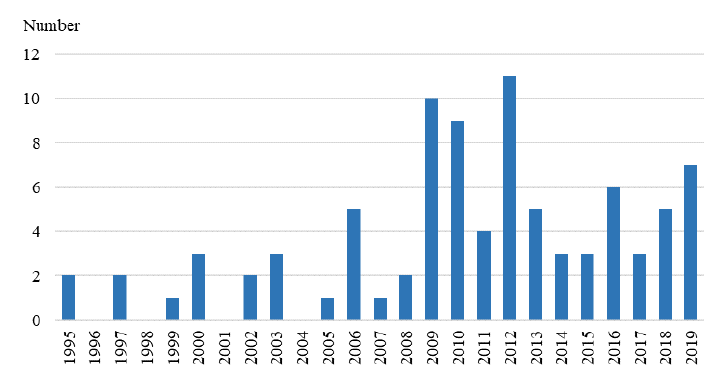
Figure 3. The publication year of selected papers.